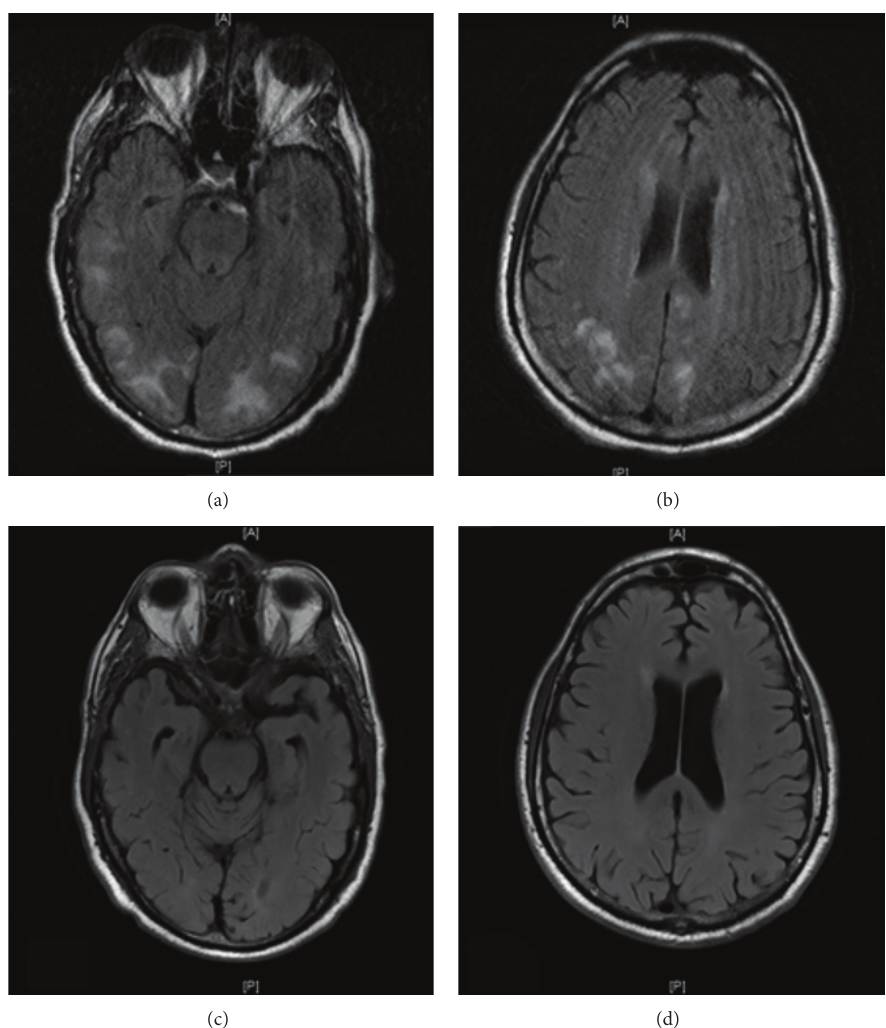
Figure 1: ((a) and (b)) Brain MRI T2 FLAIR images show leptomeningeal enhancement and high signal intensity lesions in the subcortical white matter involving both hemispheres consistent with PRES. ((c) and (d)) Brain MRI T2 FLAIR images after 3 weeks show complete resolution of the